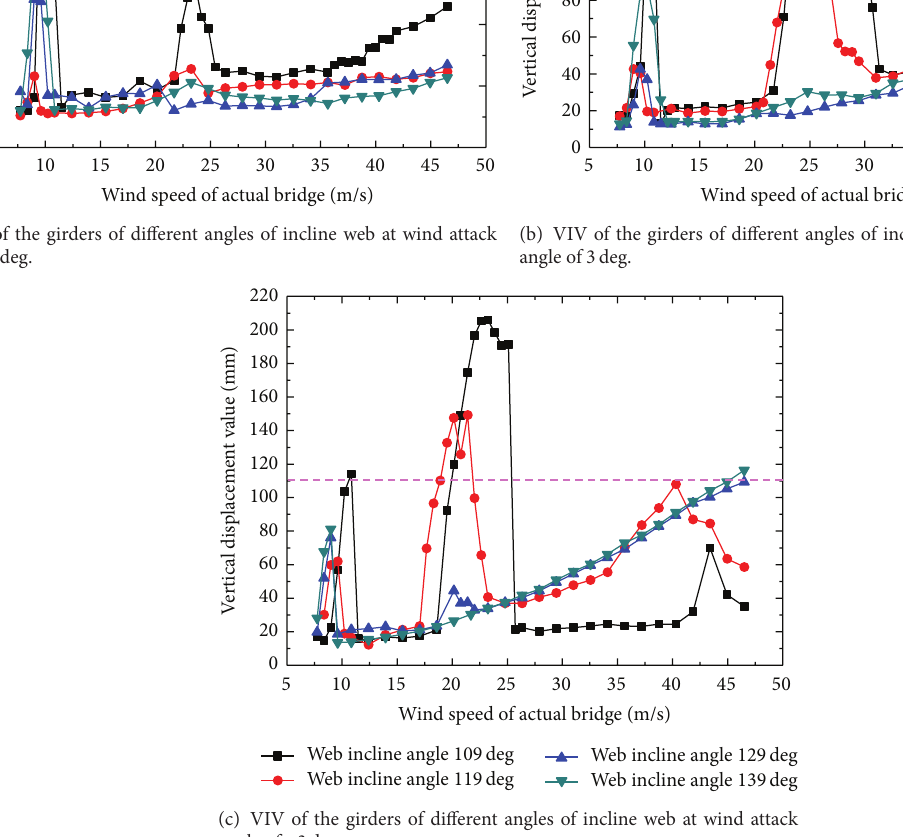
Figure 8: VIV of the girders of different angles of inclined